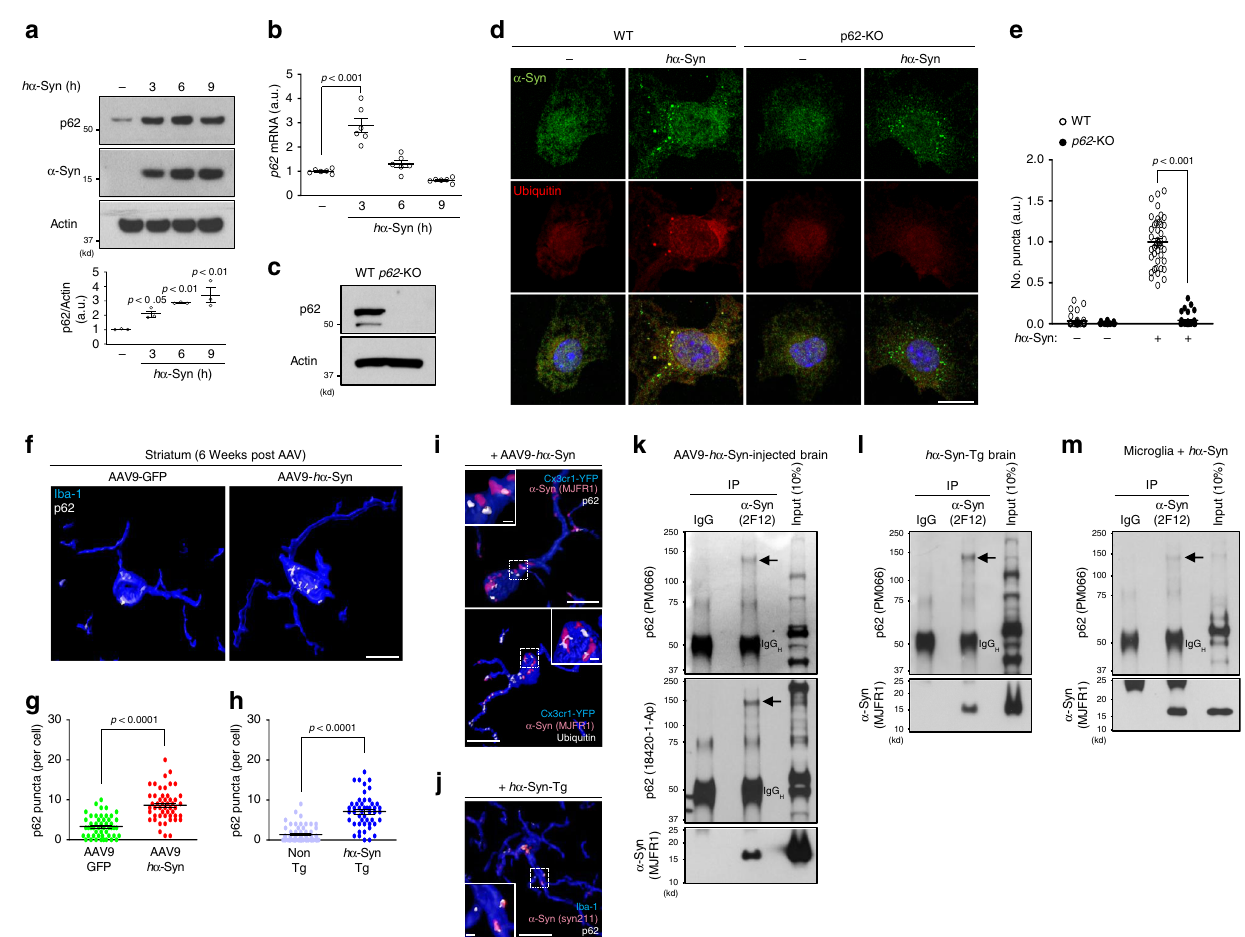
Fig. 3 p62 mediates sequestration and degradation of α -synuclein. a Microglia were treated with 250 nM h α -Syn protein for the indicated time and assayed for W.B using antibodies against p62 and human α -synuclein. The levels of p62 protein were quanti fi ed in the lower panel. n = 3 over three independent experiments. p -values were calculated by one-way ANOVA with Newman – Keuls post hoc test. F(3,8) = 13.44, p = 0.0017. b After treatment of 250 nM h α -Syn protein for the indicated time, the levels of p62 mRNA were examined by RT-qPCR. p62 mRNA was normalized to Actin mRNA. n = 6 over three independent experiments. p- values were calculated by one-way ANOVA with Newman – Keuls post hoc test. F(3,20) = 35.43, p = 3.39E-08. c The absence of p62 protein was con fi rmed in microglia obtained from p62 -KO mice by W.B. d , e WT and p62 -KO microglia were treated with 250 nM h α - Syn protein for 6 h, and stained with antibodies against human α -synuclein and ubiquitin ( d ). The number of h α -Syn/ubiquitin-positive puncta was quanti fi ed ( e ). p -values were calculated by two-way ANOVA with Bonferroni post hoc test. F(1,139) = 272.5, p = 1.44E-34 for h α -Syn-genotype interaction; F(1,139) = 315.3, p = 1.45E-37 for h α -Syn; F(1,139) = 303.7, p = 8.81E-37 for genotype. Scale bar, 10 µ m. f – h The number of p62 puncta was quanti fi ed in microglia at striatum of brains either from AAV- h α -Syn-injected mice ( n = 3, f , g , p <0.0001) or from h α -Syn-Tg mice ( n = 5, h , p <0.0001) compared with AAV-GFP-injected mice ( n = 3) and non-Tg mice ( n = 3), respectively. p -values were calculated by two-tailed Mann – Whitney U test. Scale bar, 10 µ m. i At 6 weeks post AAV- h α -Syn administration into Cx3cr1 CreER-IRES-Eyfp mice, brain slices were stained with antibodies against GFP/YFP, human α -synuclein, p62 (left panel), and ubiquitin (right panel). Scale bar, 10 µ m; 1 µ m in the magni fi ed box. j Brain sections from 10-month-old h α -syn-Tg mice were fi xed and stained using antibodies against human α -synuclein, Iba-1, and p62. Scale bar, 10 µ m; 1 µ m in the magni fi ed box. k , l , m Human α -synuclein were immunoprecipitated from AAV - h α -Syn-injected brain ( k ), h α -Syn-Tg brain ( l ), and cultured microglia treated with 250nM h α -Syn protein for 6h ( m ). Arrows indicate the high molecular weight of p62. Data are representative of at least three independent experiments. All values are reported as α -synuclein-induced p62 upregulation requires TLR4 . We next and in 10-month-old h α -Syn-Tg mice compared with controls (Fig. 3h). Furthermore, p62/ubiquitin and h α -Syn puncta asked how microglia upregulate p62 transcription in response to colocalized in EYFP-positive (AAV9- h α -Syn-injected extracellular h α -Syn. Previous reports showed α -synuclein can Cx3cr1 CreER-IRES-Eyfp ) or Iba-1-positive ( h α -Syn-Tg mice) micro- trigger TLR4 or TLR2 activation in cultured glia, which leads to glia (Fig. 3i, j). Through co-immunoprecipitation analysis, we an increase in in fl ammatory gene transcription 19,40,41 . To test TLR4 involvement, we treated microglia from Tlr4 -KO mice with found that h α -Syn interacted with speci fi c p62 protein species of h α -Syn and observed no increase in p62 protein and mRNA high molecular weight in AAV9- h α -Syn-injected brain, h α -Syn- regardless of the dose (Fig. 4a, b). Also, the number of h α -Syn/ Tg brain, and primary microglia treated with h α -Syn (Fig. 3k – m), ubiquitin-positive puncta present at 6 h after h α -Syn treatment supporting that oligomeric p62 directly binds and recruits h α -Syn was signi fi cantly decreased in Tlr4 -KO microglia compared with into autophagosomes. The above data thus demonstrates that h α - control cells (Fig. 4c). In addition, we treated cultures with TAK- Syn-induced p62 upregulation in microglia confers a selective 242, an inhibitor of TLR4 signaling by selectively binding to autophagic degradation of ingested h α -Syn.